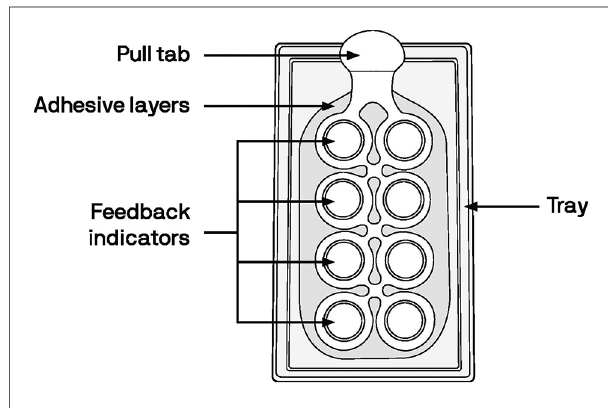
FIGURE 2 Diagram of the MAP prototype used in this assessment; dimensions were 14.5 cm×6.25 cm (5.75 inches by 2.5